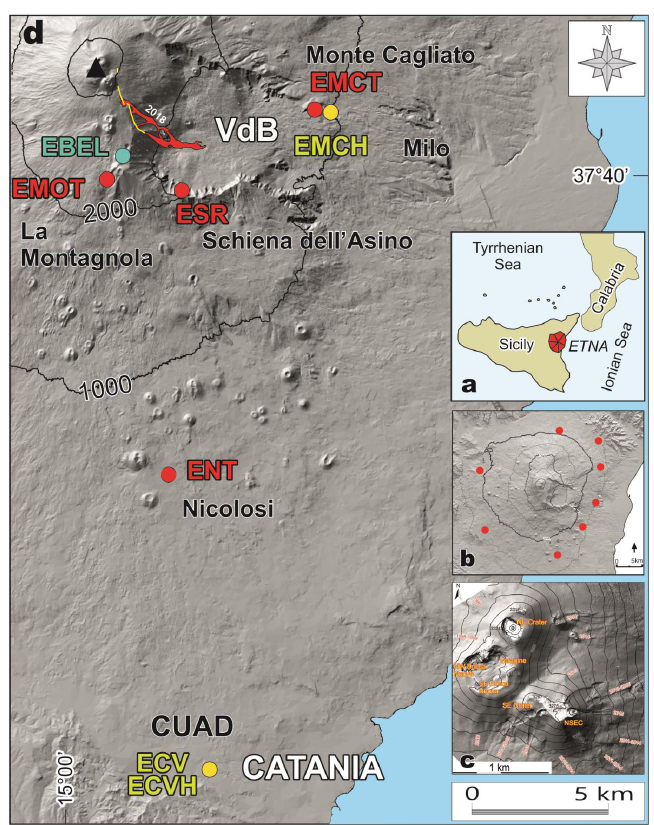
Figure 1. ( a ) Map of southern Italy and location of the Etna volcano. ( b ) Location (red dots) of the Differential Optical Absorption Spectroscopy (DOAS) stations belonging to the Flame network around the flanks of Mount Etna. ( c ) Map of Etna’s summit with the names of the main active craters: NE Crater, Voragine, SE Crater, New SE Crater (NSEC), and Bocca Nuova comprising two pits (NW Bocca Nuova and SE Bocca Nuova), modified after Neri et al., 2017. ( d ) Map of the SE flank of the Etna volcano, with the black triangle showing the position of the summit craters magnified in (b), the 2018 lava flow field in red with the yellow lines for the eruptive fissures, and the location of the monitoring cameras used in this paper and comprising the INGV-OE network. The red dots are the thermal cameras Schiena dell’Asino (ESR), La Montagnola (EMOT), Nicolosi (ENT), and Monte Cagliato (EMCT); with the yellow dots the visual cameras CUAD (ECV) and CUAD, wide angle (ECVH), and Monte Cagliato, wide angle (EMCH). The blue dot indicates the location of the radiometer (EBEL). VdB = Valle del Bove depression.